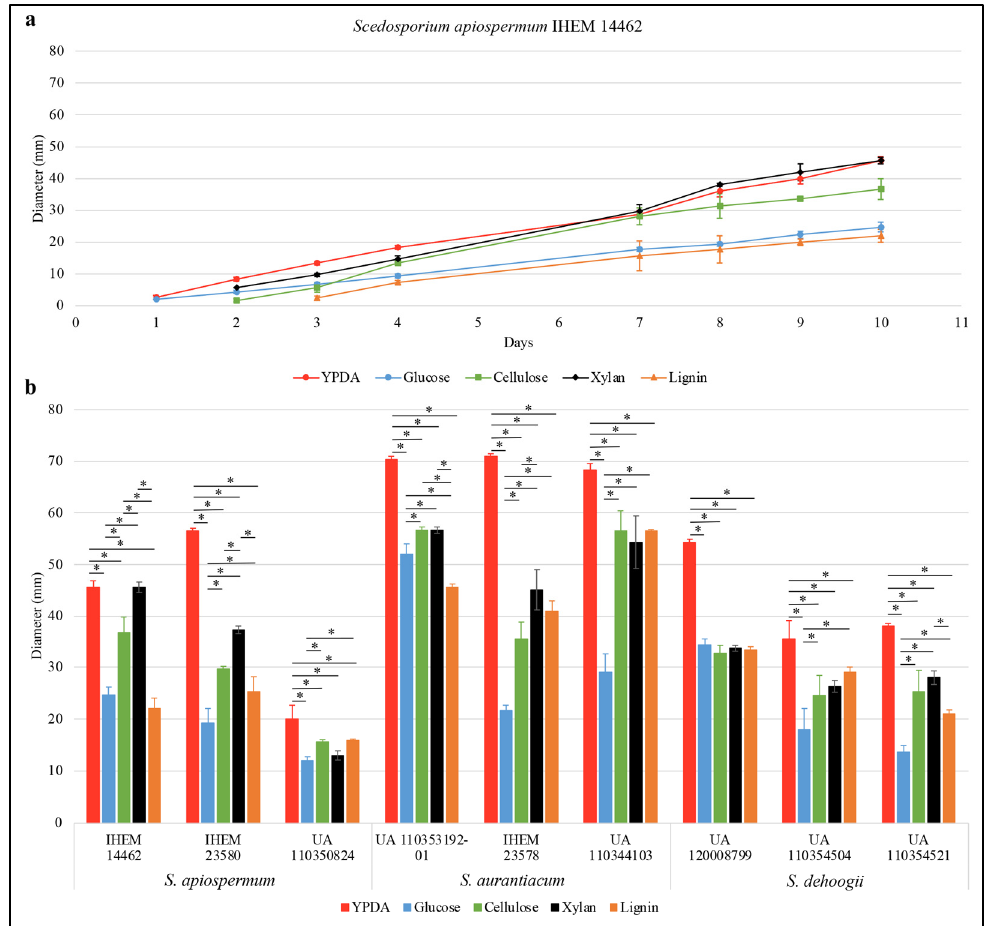
Figure 1. ( a ) Kinetics of growth of Scedosporium apiospermum IHEM 14462 on a synthetic agar-based medium Scedo-Select III containing a unique carbon source: glucose for control conditions, lignin, cellulose or xylan. ( b ) Colony diameter (mm) after 10 days of culture on agar-based media according to the carbon source. Fungal culture collections: IHEM, clinical strains; and UA, clinical or environmental strains. For statistical analyses, an ANOVA–Tukey test was performed to compare growth at 10 days within each culture conditions, * p -value < 0.05.